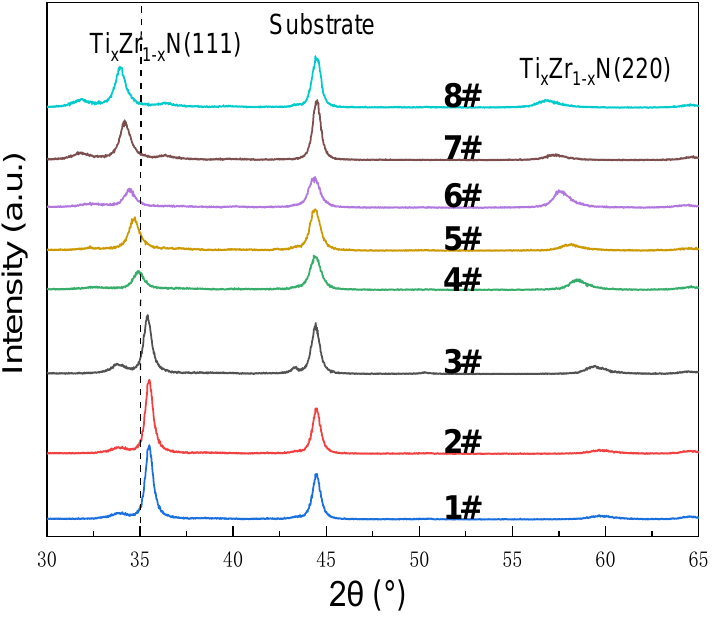
Figure 4. XRD patterns of the films. Notably, the films exhibited certain textures. The preferred growth orientations of the films varied with an increase in the Zr/Ti molar ratio. When the Zr/Ti molar ratio in Ti x Zr 1 − x N hard films was lesser than 40:60 or greater than 60:40, the films tended to grow in a preferred orientation on the (111) crystal plane, as shown in Figure 4 (1#, 2#, 3# and 7#, 8#). When the Zr/Ti molar ratio was approximately 40:60 or 60:40, preferred growth orientations in both the (111) and (220) crystal planes were observed, as shown in Figure 4 (4# and 6#). However, when the Zr/Ti molar ratio approached 50:50, the preferred growth orientation returned to the (111) crystal plane. Considering that the properties of the films were similar, we conclude that the Zr/Ti molar ratio is the only, or the most important, factor that influences the preferred growth orientation in the films. The occurrence of texture in ternary nitride films, such as TiAlN, TiCrN, and AlCrN films, is a common phenomenon. The preferential growth orientations in films of FCC solid solutions vary with the deposition conditions or proportions of metal constituents, or both. Sometimes, the transformation of the preferential growth orientations is accompanied by the occurrence of a second nitride phase; for example, the hexagonal AlN phase in the TiAlN and AlCrN films [20–25]. For Ti x Zr 1 − x N films, many studies show that the films deposited by ion plating tend to grow in the (111) crystal plane in a wide range of compositions. Examples of such films are the ones with a Zr/Ti molar ratio of 50:50 deposited by cathodic arc ion plating at bias voltages of 120–210 V at 450 ◦ C [3], a molar ratio of 65:35 prepared at 40 V and 400 ◦ C [2], a molar ratio of 66.5:33.5 prepared at 250 V [6], molar ratios from 24:76 to 40:60 prepared at 120 V and at 450–500 ◦ C [4], and molar